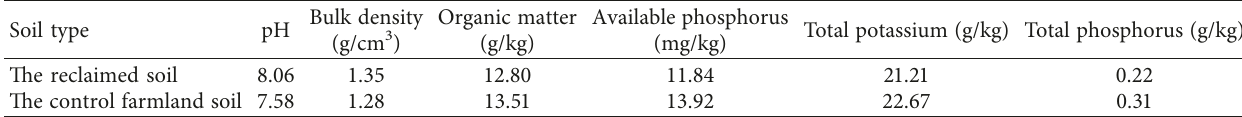
Figure 3: Land reclamation process of mining wasteland. (a) Original condition of mining subsidence area. (b) Filling coal fly ash and coal gangue. (c) Covering the surface soil. Table 1: Physical and chemical indicators of the reclaimed soil and the control farmland soil.